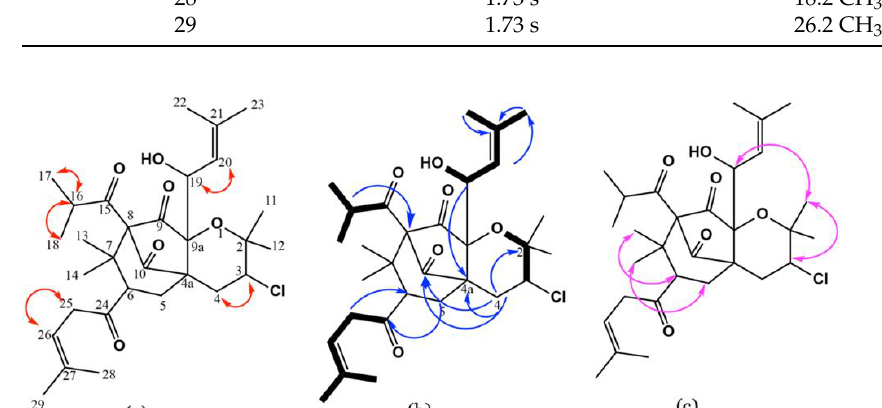
Figure 3. Important COSY ( a ), HMBC ( b ), and NOESY ( c ) correlations of 2